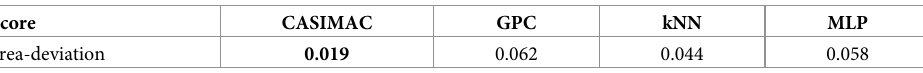
Table 4. Calibration score. Calibration score measured in terms of the area-deviation (area between each curve and the diagonal reference line) for the calibration curves from Fig 8, which refer to the pine data set. The best result is highlighted in